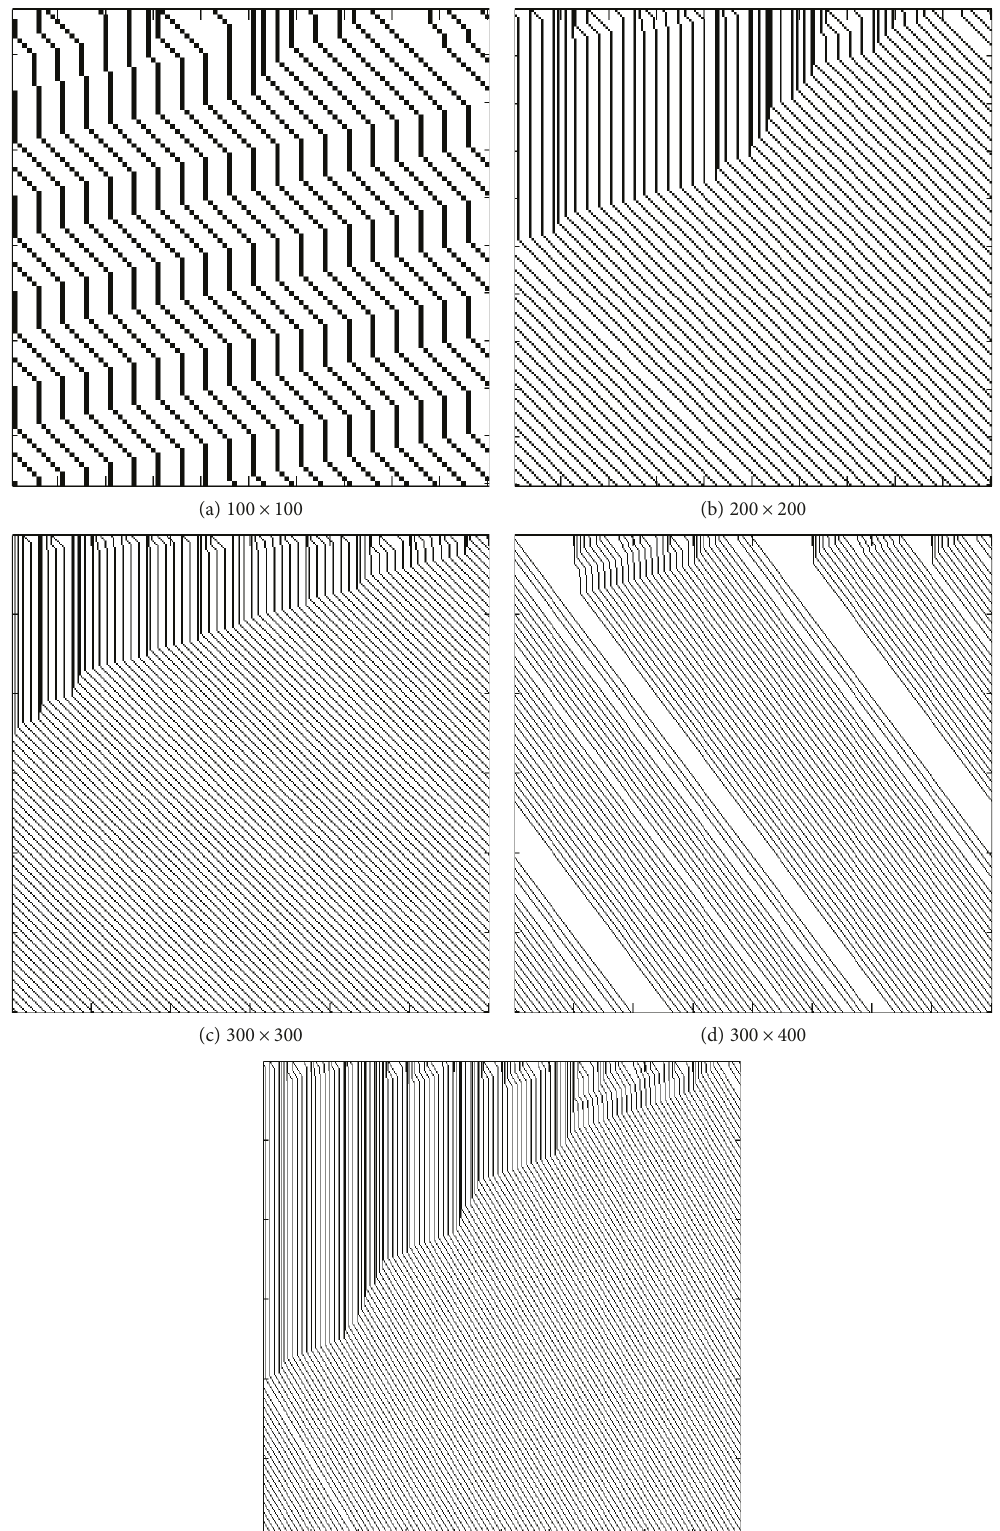
Figure 13: Evolutions of the cellular automaton for disordered initial con fi gurations of di ff erent sizes (number of generations × number of